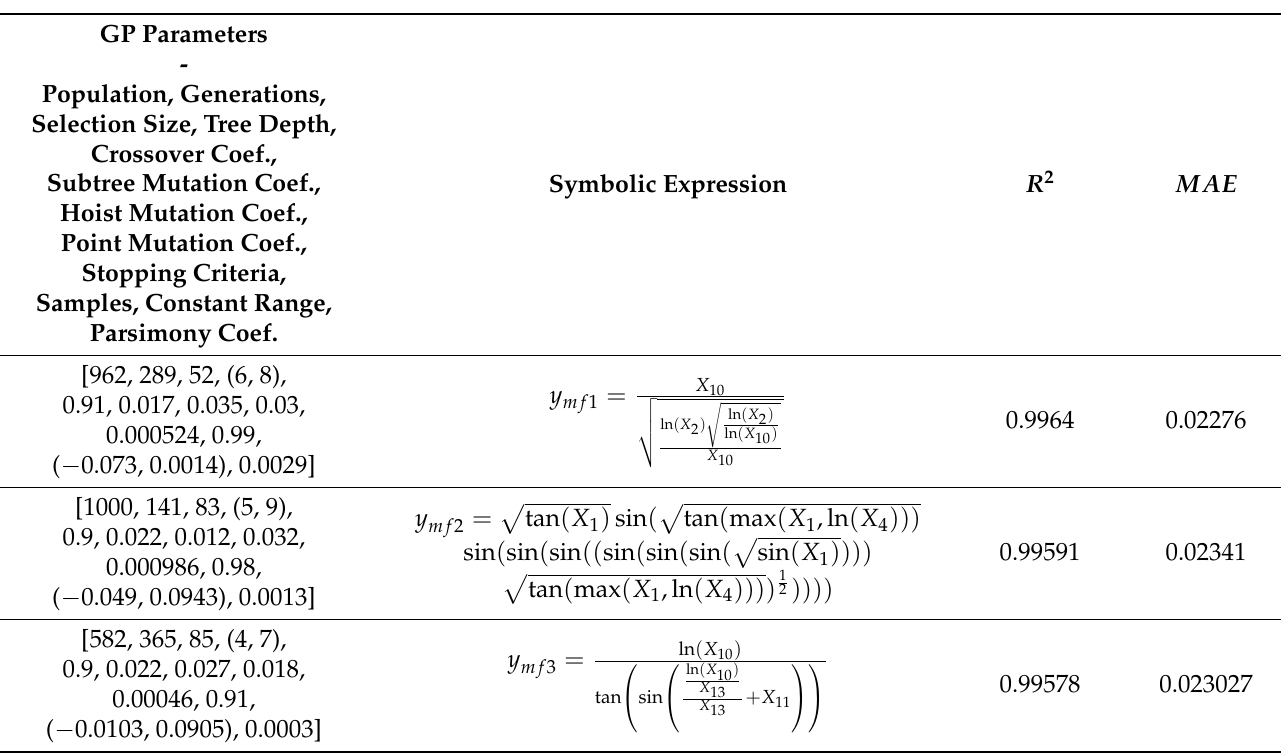
Table 5. Three best symbolic expressions for fuel flow estimation without decay state coefficients with corresponding R 2 and MAE